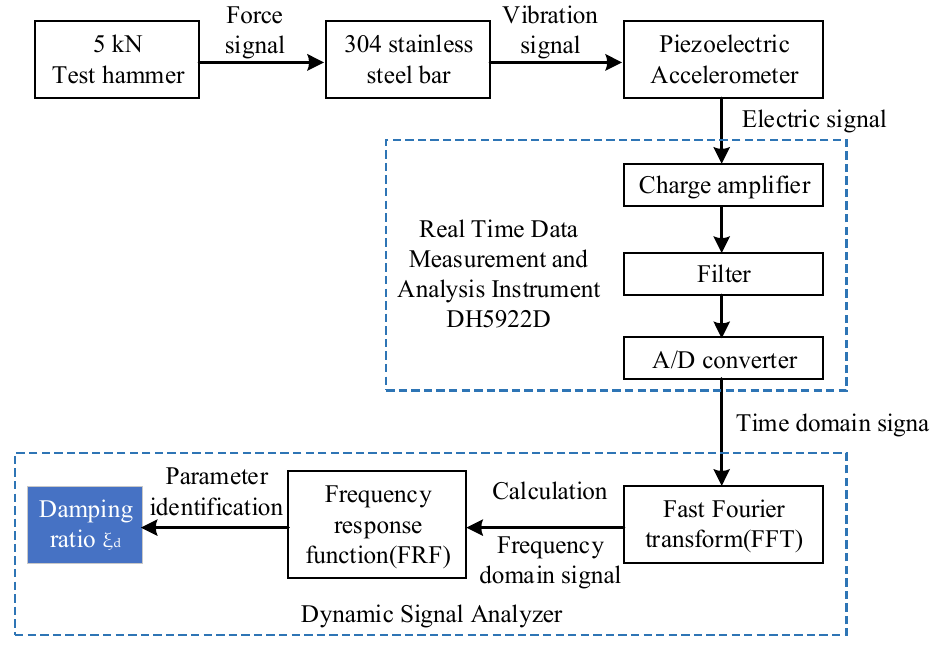
Figure 7. Schematic block diagrams of standard modal test.